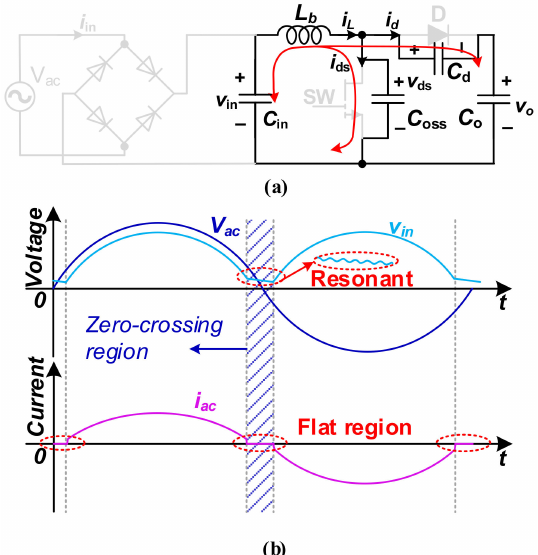
Figure 4. Typical operating circuit and waveforms in the crossover distortion phenomenon: ( a ) operating circuit during the non-power transfer period; ( b ) line voltage and current waveforms of the crossover distortion